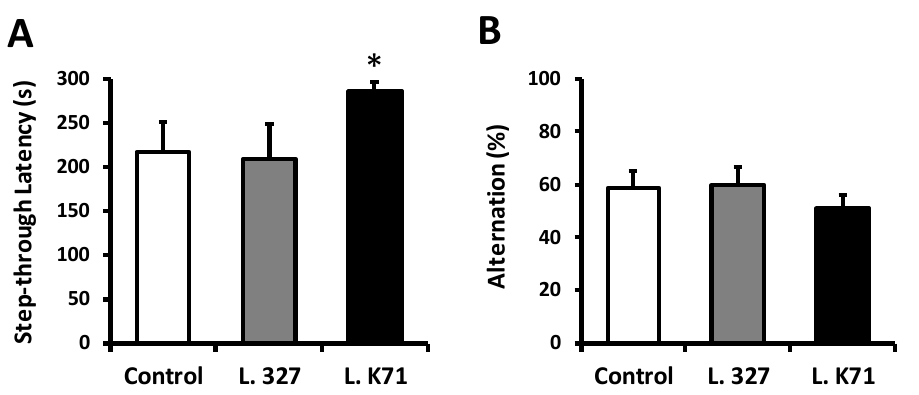
Figure 2. Effects of 43-week Lactobacillus strain administration on fear-motivated learning and short- term memory in SAMP8 mice. ( A ) Step-through latency in the passive avoidance test; ( B ) Spontaneous alternation behavior in the Y-maze test. Data are presented as mean ± SEM; n = 10 mice per group; * p < 0.05 vs. the control group.